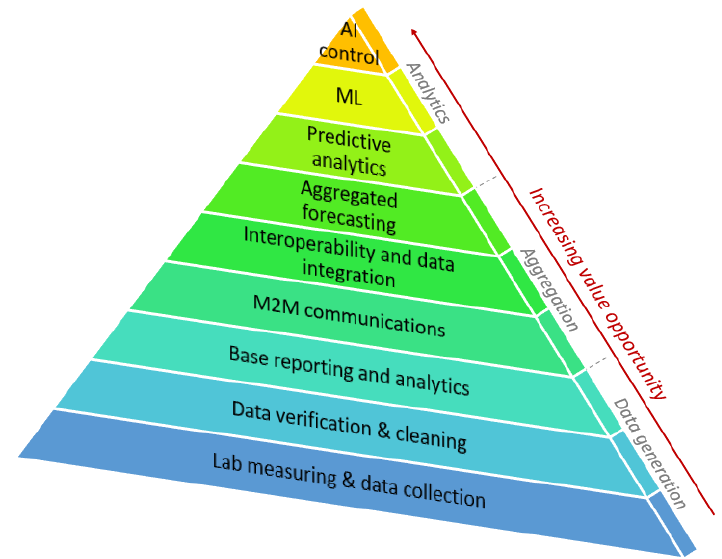
Figure 6. Level of the data processing. The layers show the integration of data into the corporate control system. The higher the level of the pyramid, the more complex the data-based